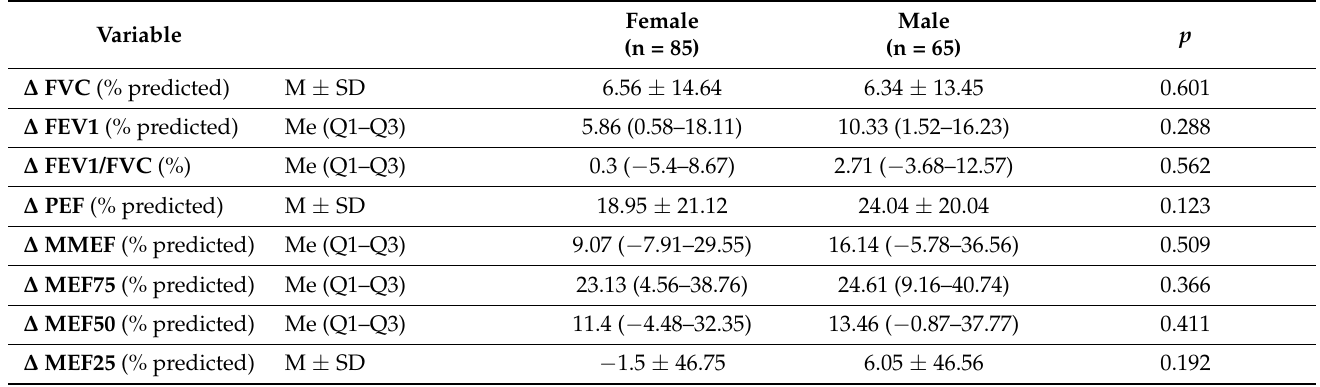
Table 5. Relationships between the difference in spirometric results before and after rehabilitation and